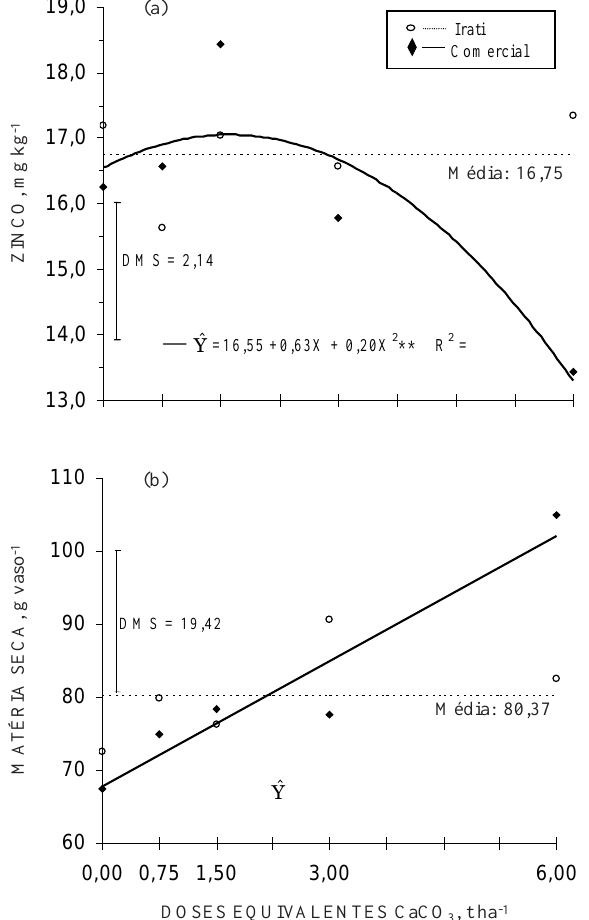
Figura 4. Concentração de Zn na planta de milho (a) e produção de matéria seca das plantas de milho por vaso (b) em função de doses crescentes dos distintos materiais corretivos (DMS: Diferença em equivalentes de CaCO 3 mínima significativa para diferentes materiais corretivos a uma mesma dose).